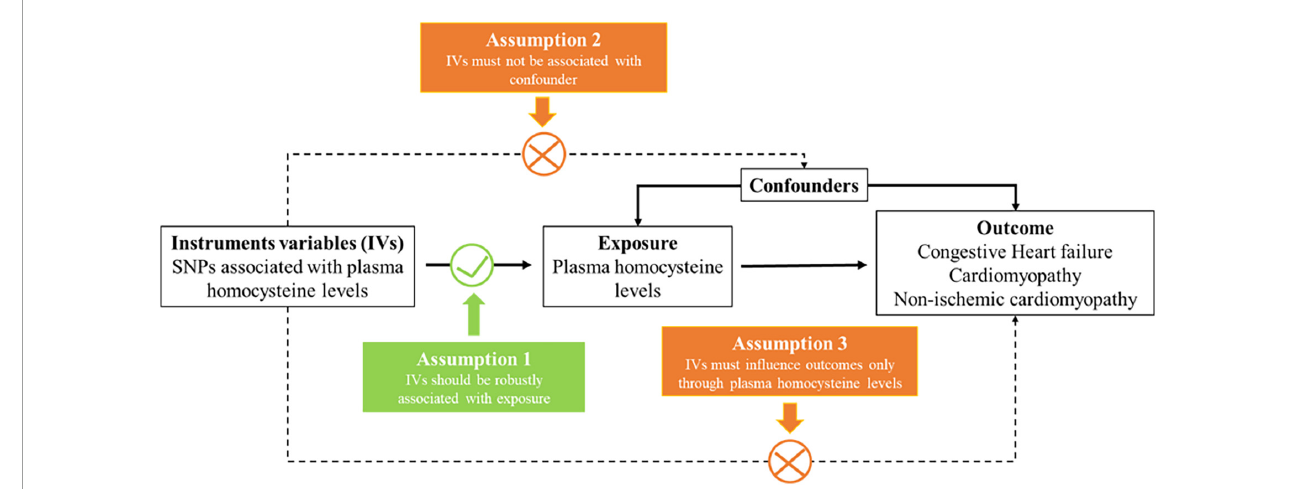
FIGURE2 Flow chart of this Mendelian randomization study. GWAS, genome-wide association study; IVW, inverse-variance weighted; MR, Mendelian randomization; MR PRESSO, MR pleiotropy residual sum and outlier; SNP, single-nucleotide polymorphism.